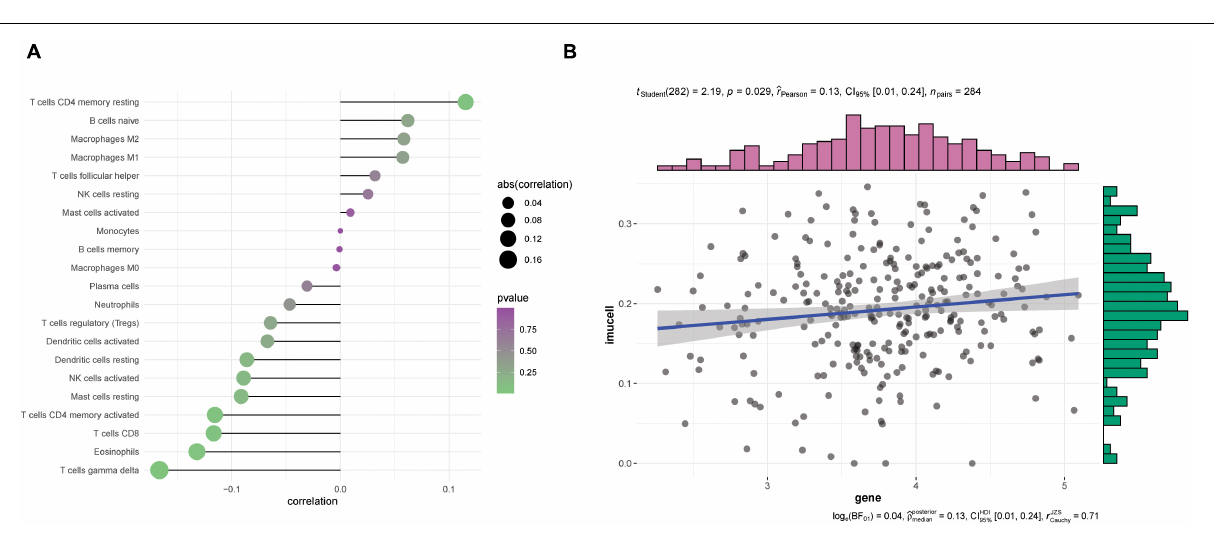
FIGURE 6 | Correlation between MAVS expression and infiltrating immune cells. (A) Correlation between MAVS expression and infiltrating immune cells. (B) The linear relationship between MAVS expression and the delta gamma T cells is